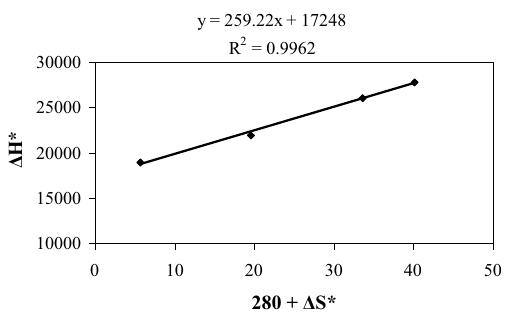
Fig. 3 Plot of enthalpy of activation (∆ H # , J mol −1 ) versus entropy